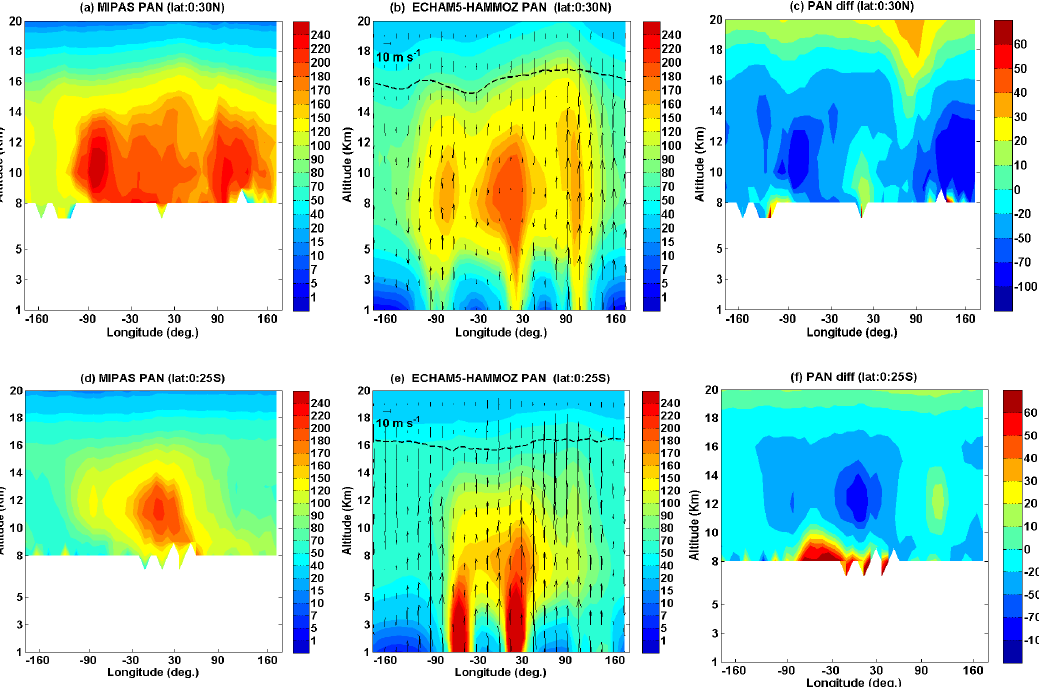
Figure 4. Longitude–altitude cross section of PAN (ppt) averaged for the monsoon season and 0–30 ◦ N; (a) MIPAS-E climatology (b) ECHAM5–HAMMOZ CTRL simulations. (c) Difference in PAN (ppt) (MIPAS-E–ECHAM5–HAMMOZ). PAN (ppt) averaged for the monsoon season and 0–25 ◦ S (d) MIPAS-E climatology (e) ECHAM5–HAMMOZ CTRL simulations (f) difference in PAN (ppt) (MIPAS- E–ECHAM5–HAMMOZ). ECHAM5–HAMMOZ simulations are smoothed with averaging kernel of MIPAS-E. Wind vectors are indicated by black arrows in (b) and (e) . The vertical velocity field has been scaled by 300. The black line in (b) and (e) indicates the tropopause.